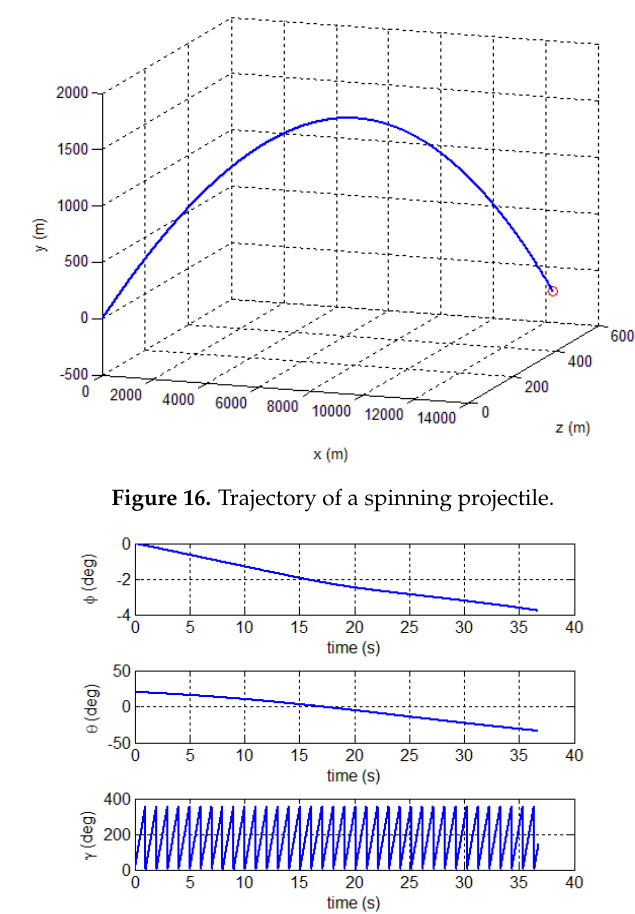
Figure 14. Measurement error after compensation. Figure 15. Total intensity of the magnetic field.